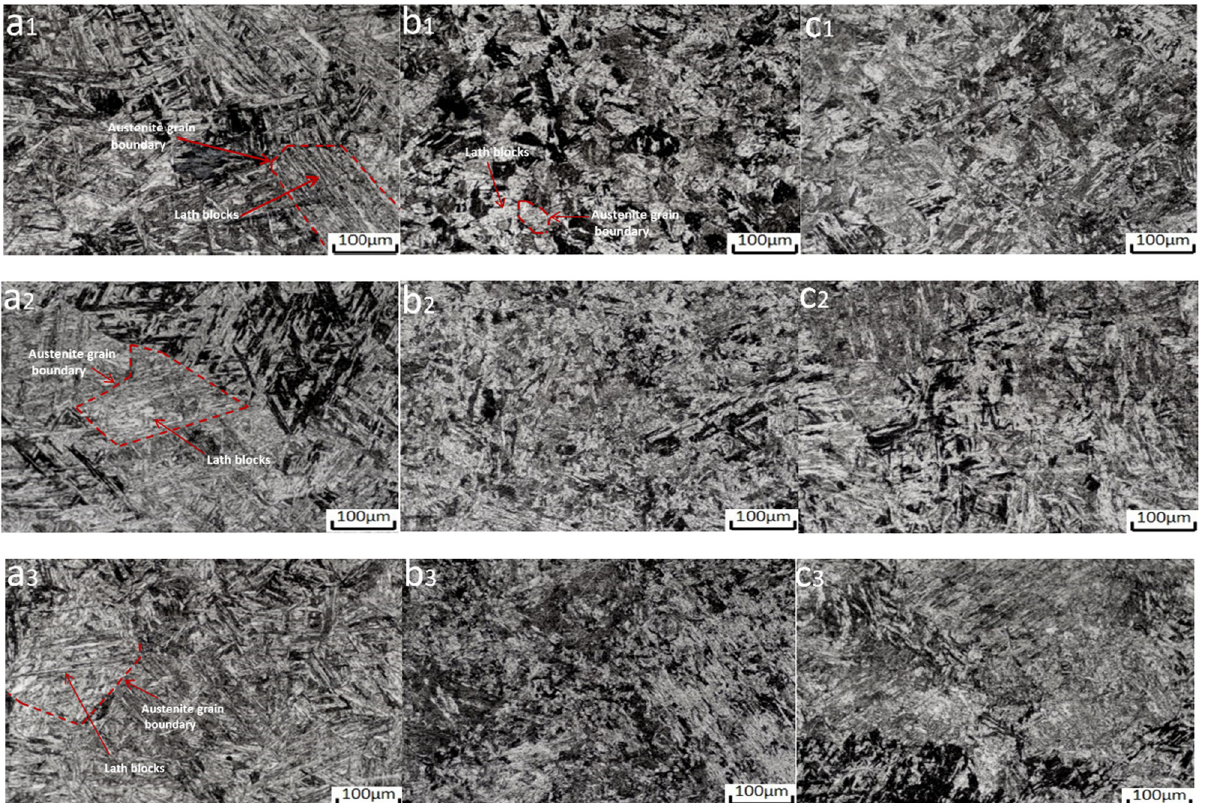
Figure 4: 1 – 3# Metallographic morphology of welded joint section at di ff erent thickness positions ( a, base metal zone; b, heat a ff ected zone; c, weld zone )